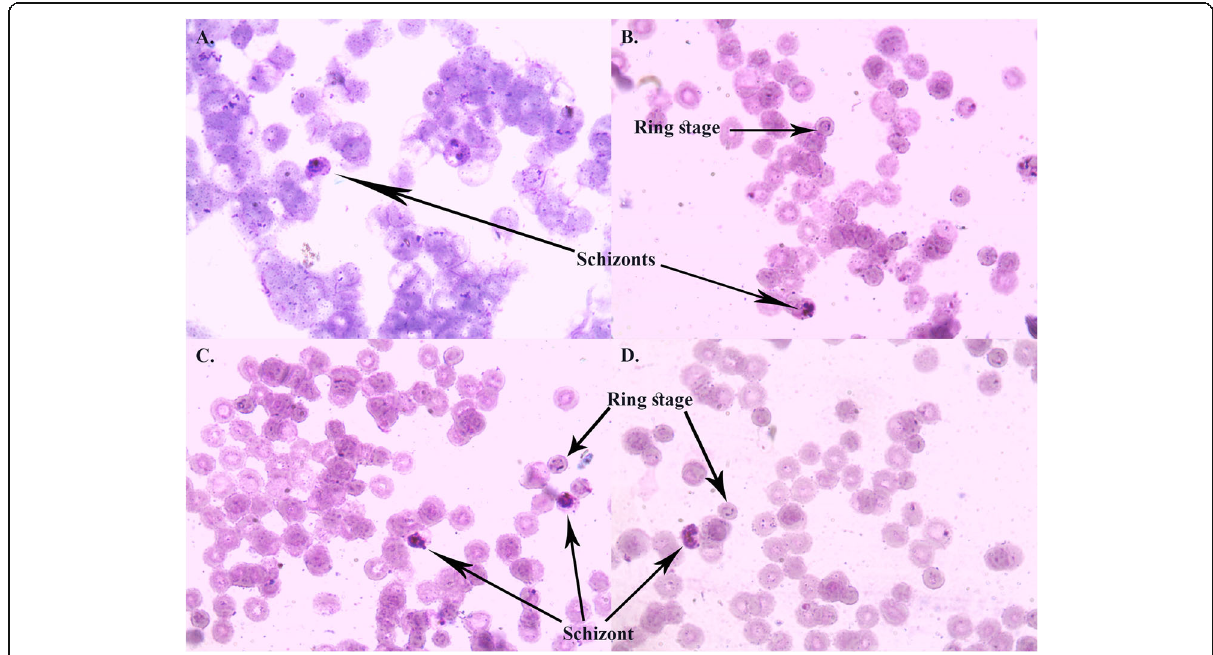
Fig. 2 Representative photomicrographs taken during the observation under light microscope at 1000X (oil emersion) magnification showing infected erythrocytes by different strains of P. falciparum ; a . 3D7 without treatment, b . 3D7 with treatment (50 μ g/ml), c . RKL-9 without treatment and d . RKL-9 with treatment (50 μ g/ml)